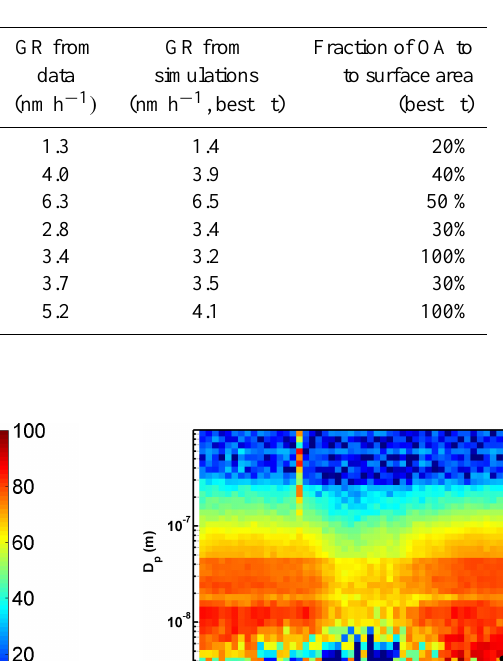
Table 2. The particle formation events analyzed in detail with the aerosol dynamics box model, along with the particle growth rates determined from the observational data and the simulated evolution of the freshly-formed nucleation mode corresponding to the best fit between the observations and the modeled growth.